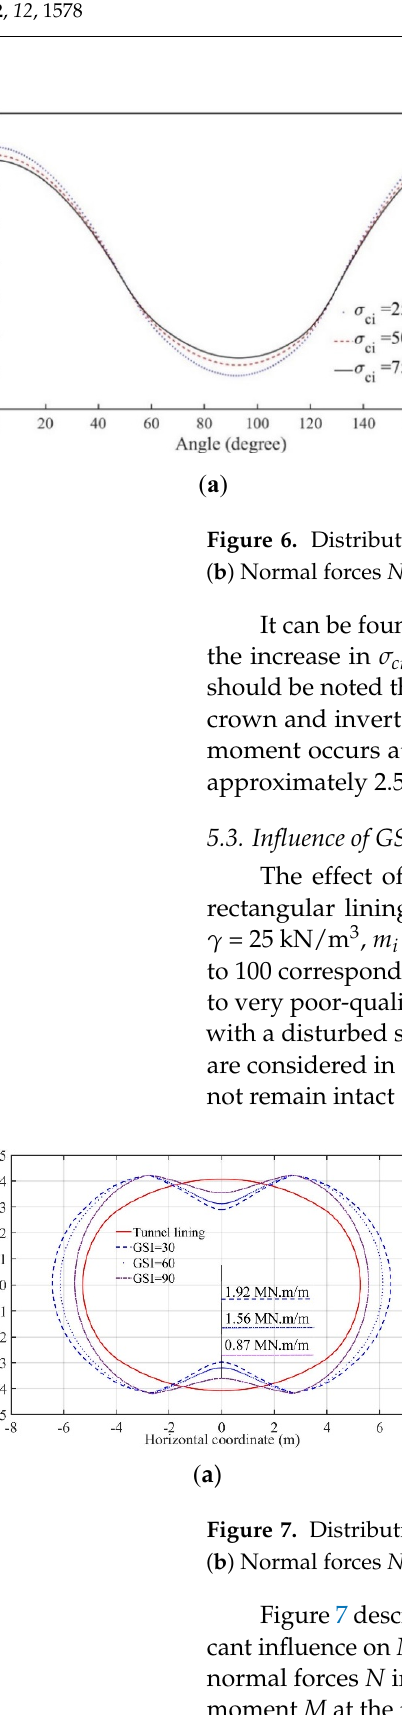
( b ) Figure 5. Distributions of internal forces of lining under different H. ( a ) Bending moments M ; ( b ) Normal forces N . 5.2. Influence of 𝜎 (cid:3030)(cid:3036) on the Internal Forces of a Quasi-Rectangular Tunnel The impact of the rock unconfined compressive strength 𝜎 (cid:3030)(cid:3036) on the internal forces of the quasi-rectangular tunnel lining is given in this section, and the parameters shown in Section 5.1 are also adopted in the analysis, except γ = 25 kN/m 3 and H = 15 m. The values of 𝜎 (cid:3030)(cid:3036) = 25 MPa, 50 MPa, and 75 MPa are taken into consideration. The internal forces are shown in Figure 6 considering various 𝜎 (cid:3030)(cid:3036) .